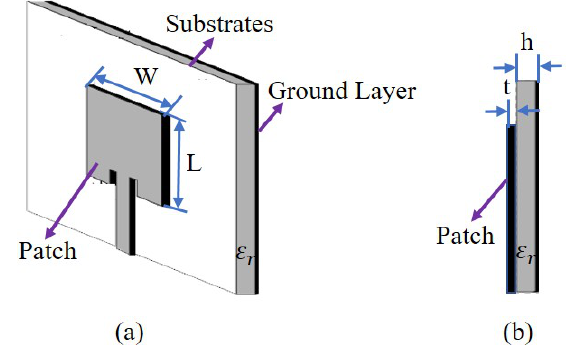
Figure 3. Typical microstrip antenna structure. ( a ) Microstrip antenna. ( b ) Lateral